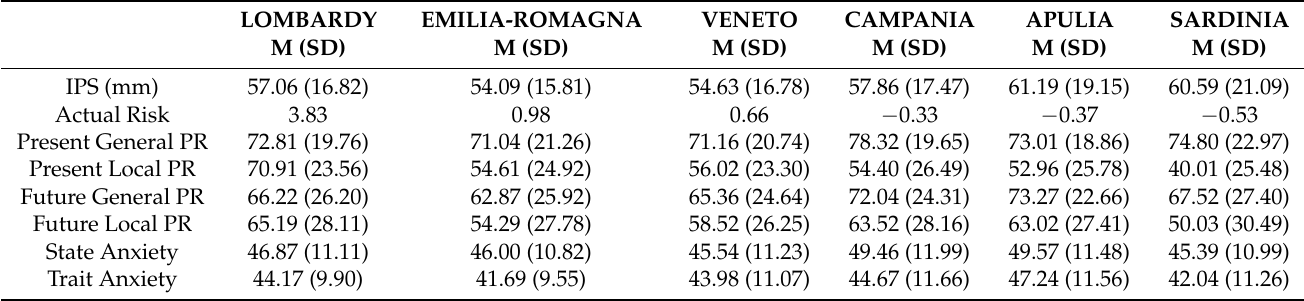
Table 1. The table shows the mean IPS (mm) from the IVAS task, actual risk values and mean perceived risk (PR) values for the present general, present local, future general and future local dimensions and state and trait anxiety as a function of the six Italian